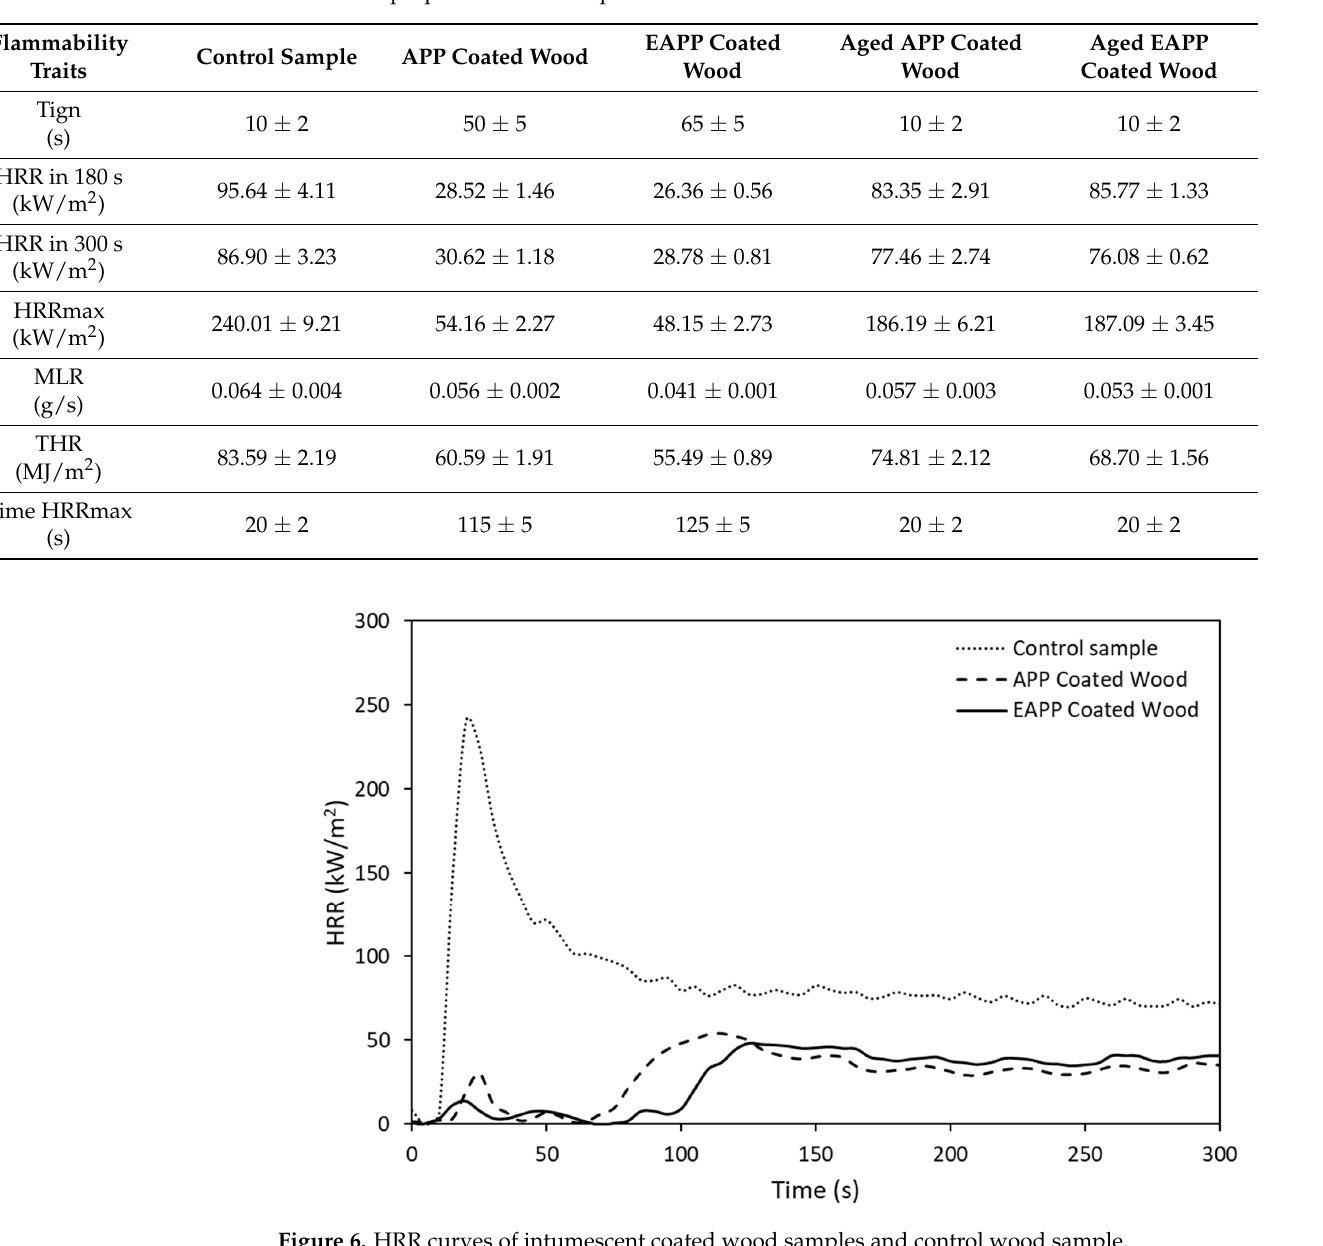
Figure 6. HRR curves of intumescent coated wood samples and control wood sample. After the intumescent coated wood samples were exposed to the weathering condi- tions, an increase in the MLR values was observed, and the residue obtained after burning was slightly higher when compared to the non-aged samples as seen in Figure 9. The THR values of all samples are also reported in Table 5. On burning, the control sample released a total heat of 83 MJ/m 2 , while the APP Coated Wood and EAPP Coated Wood samples released 60 and 55 MJ/m 2 of heat, respectively. The decrease in THR values by almost 35% for intumescent coated wood samples indicate that the modified fire retardant could significantly reduce the total heat released and enhance the fire-retardant properties of the studied